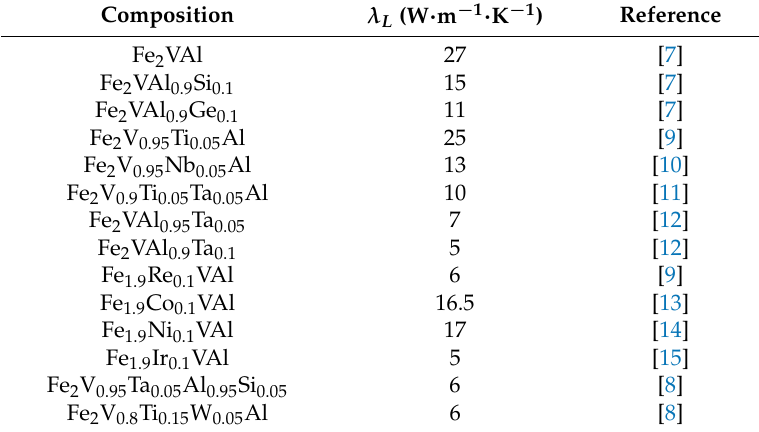
Table 1. Compilation of published lattice thermal conductivity values, measured at 300 K in substituted Fe 2 VAl